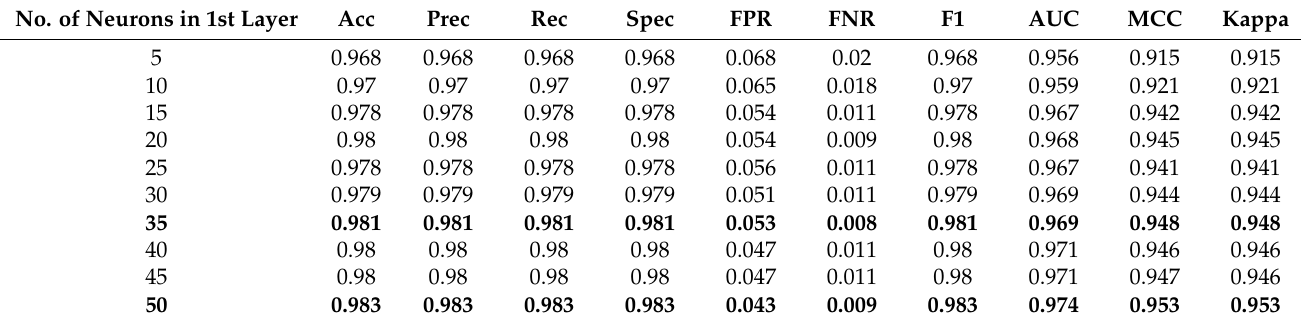
Table 4. Deep learning results with a different number of neurons in the hidden layer of the Dense-1 model. Best results are given in bold.